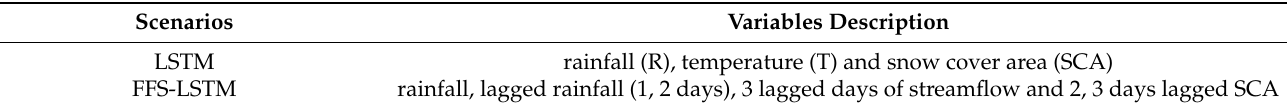
Table 2. Dataset input